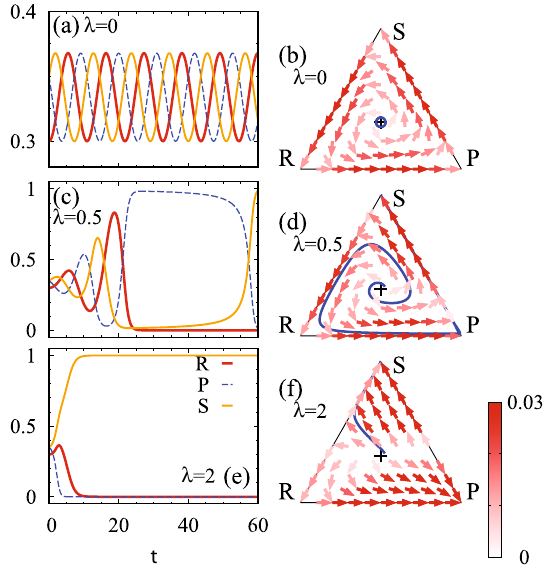
Figure 2. Dynamical properties of the RPS game (1). Panels ( a , c , e ) display the time-evolution of the 0 , 0.5, and 2, respectively. The data are obtained by employing a fourth order Runge- population x for (cid:31) = 0.05 . We set the initial condition as n (cid:31) t RK with (cid:31) t RK Kutta method 68 with discretized time t n = = x ( t 0.1 . The time-evolution is computed up to t n 0 ) ( 1 δ 0 , 1 δ 0 / 2, 1 δ 0 / 2 )/ 3 with δ 0 = = = − + + Panels ( b , d , f ) are phase plots for x . The arrows denote the direction of the dynamics (� x 1 , � x 2 , � x 3 ) which is x T A x )� t with (cid:31) t 0.1 . The black crosses denote the fixed point specified x I ( e T A x computed by � x I I = = − ( 1, 1, 1 )/ 3 . In panels ( b , d , f ), the blue line denotes the population density x ( t ) plotted in panels ( a , c , e ), by c =